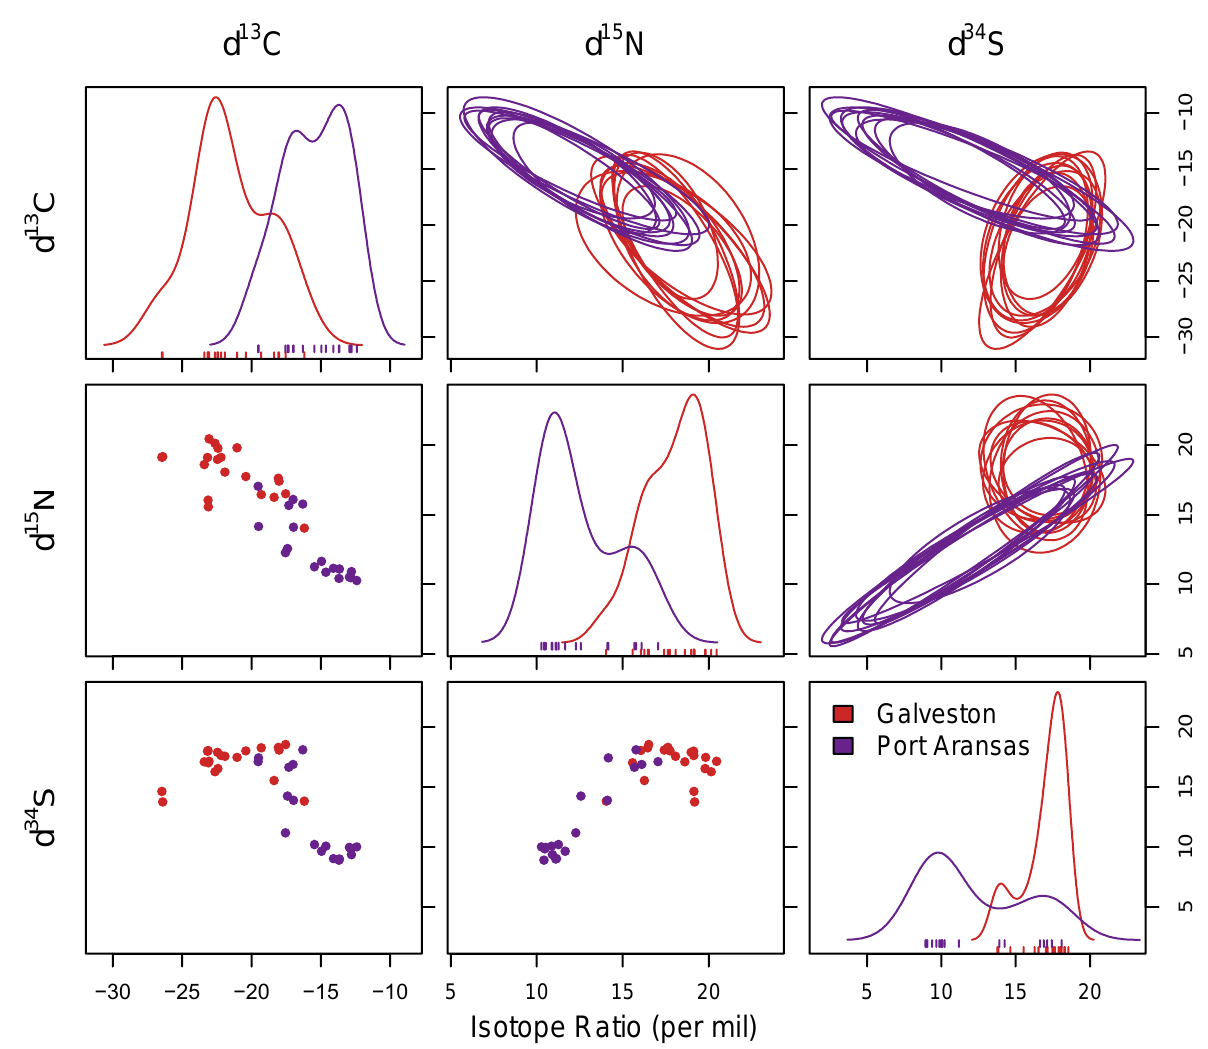
Figure 2. Niche separation of sheepshead using stable isotope values ( δ 13 C, δ 15 N, and δ 34 S) measured in muscle samples. Six comparisons were made across each of the three stable isotope values ( δ 13 C vs. δ 15 N, δ 34 S vs. δ 15 N, and δ 13 C vs. δ 15 N) as well as single isotope values. The bottom left shows the depictions of the raw data as a simple biplot and diagonally are the distributions for sheepshead from both locations for single isotope values. The upper right-hand corner shows 10 random draws of niche region that were estimated using each combination generated using Monte Carlo